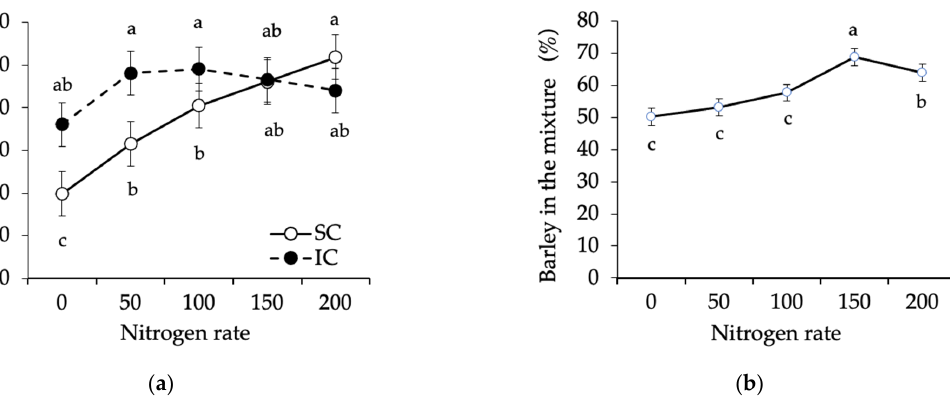
Figure 8. Indices of intercropping performances: ( a ) total grain yield production (DM g m − 2 ) in the equivalent surface area, per Equations (1) and (2); ( b ) percentage of barley in the grain mixture. Values are means of ( a ) two years, five N rates, two cropping systems, and three replicates (cropping system × nitrogen rate interaction) and ( b ) two years and three replicates (nitrogen rate main effect). Vertical lines represent HSD and values with the same letter are not statistically different for p ≤ 0.05. SC = sole crop; IC = intercrop.